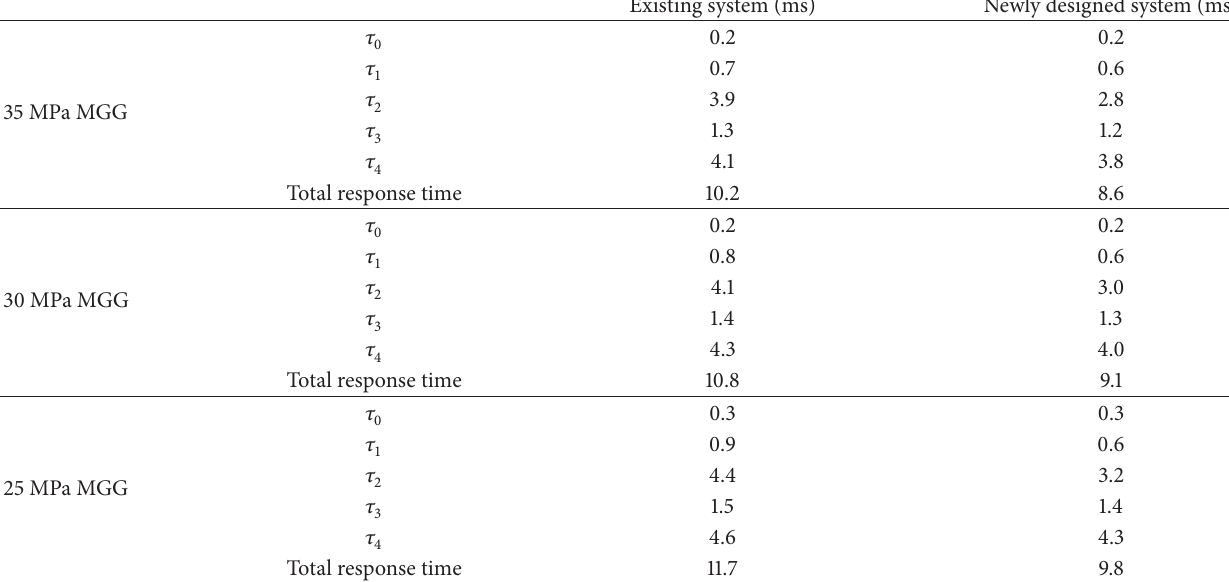
Table 8: Comparison of response times of existing AHLS and newly designed AHLS with different actuator specifications. Existing system (ms)